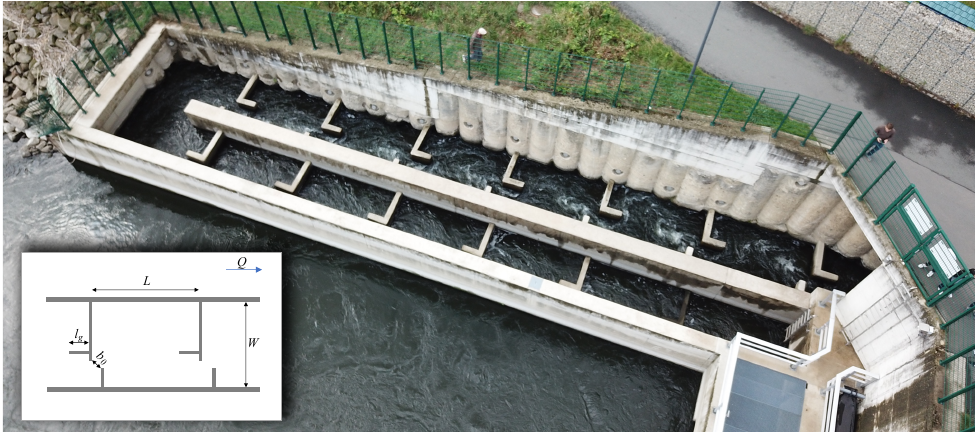
Figure 1. Photograph of an examplary vertical slot pass at a weir in North-Rhine Westphalia,